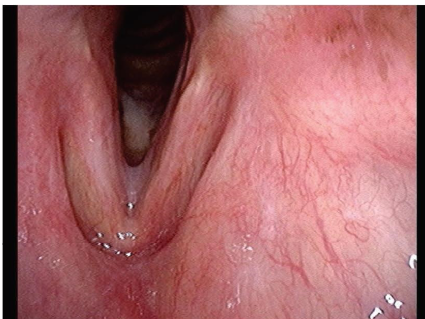
Figure 3: Laryngoscopy fndings after 6months of treatment. Te elevated lesions on both sides had